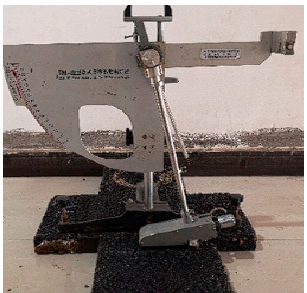
Figure 6. British pendulum test.